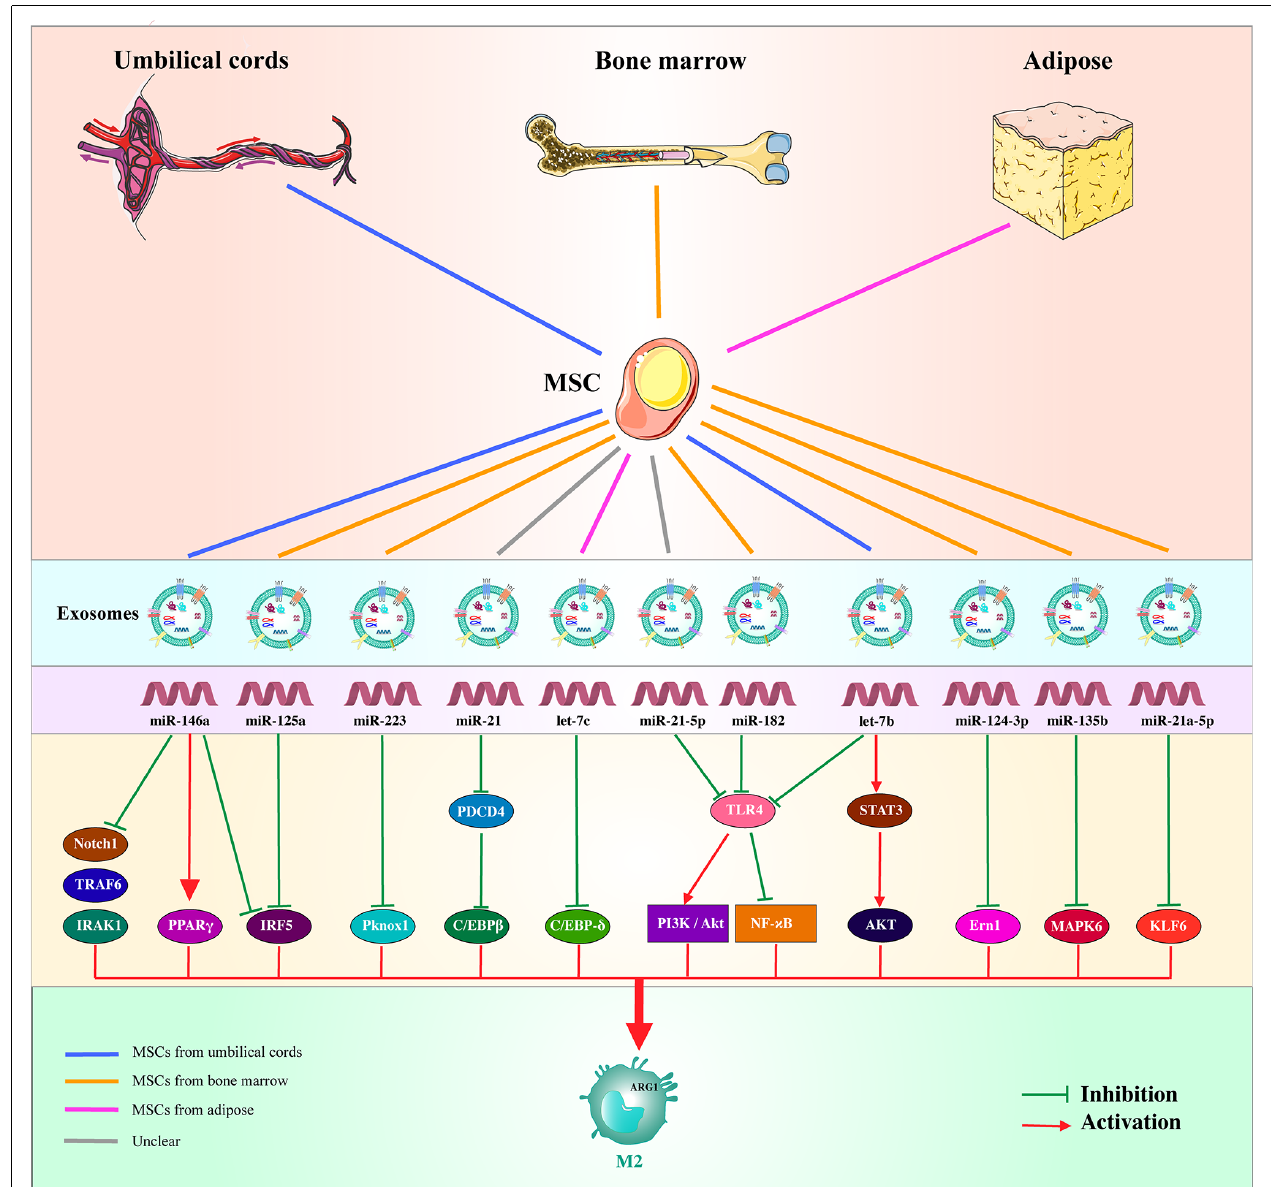
FIGURE 2 | Diagram illustrates MSC-derived exosomal miRNAs that induce alternative activation of macrophages and their corresponding